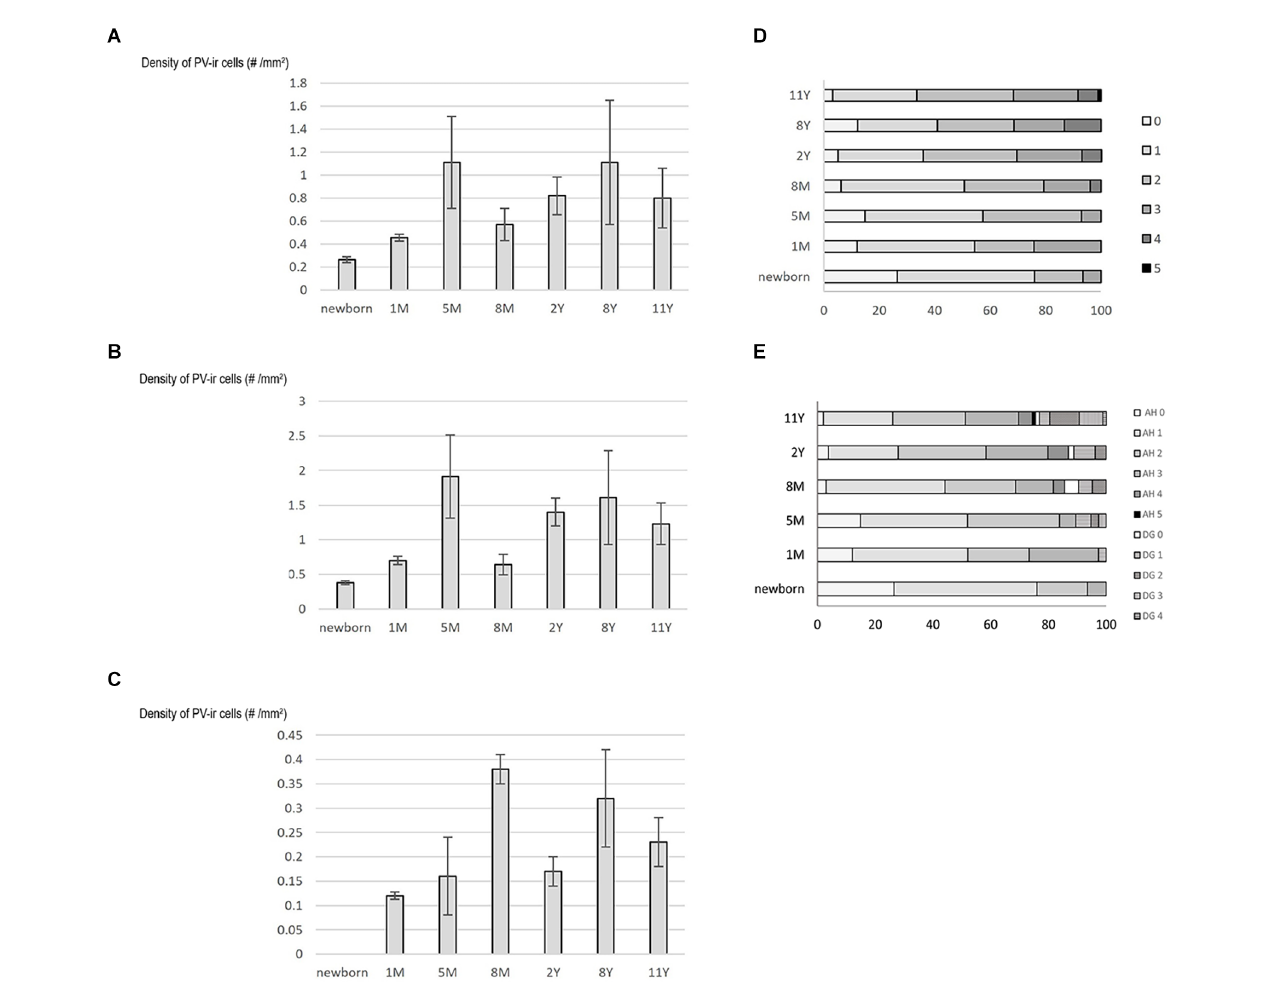
FIGURE5 Graphs demonstrating results of quantification on PV-immunoreactive neurons in the developing hippocampal formation. Density (cell number/1 mm 2 area) of PV-immunoreactive neurons is shown in the whole hippocampal formation (A) , in Ammon’s horn (B) , and in the dentate gyrus (C) . (D) and (E) Graphs demonstrate data on dendritic development of the PV-immunoreactive neurons in the entire hippocampal formation (D) and in the Ammon’s horn and dentate gyrus separately (E) . Percentage of PV-immunoreactive neurons with 0–5 primary dendrites shown in different age groups. Abbreviations: AH, Ammon’s horn; DG, dentate gyrus; M, month; PV-ir, PV-immunoreactive; Y, years.